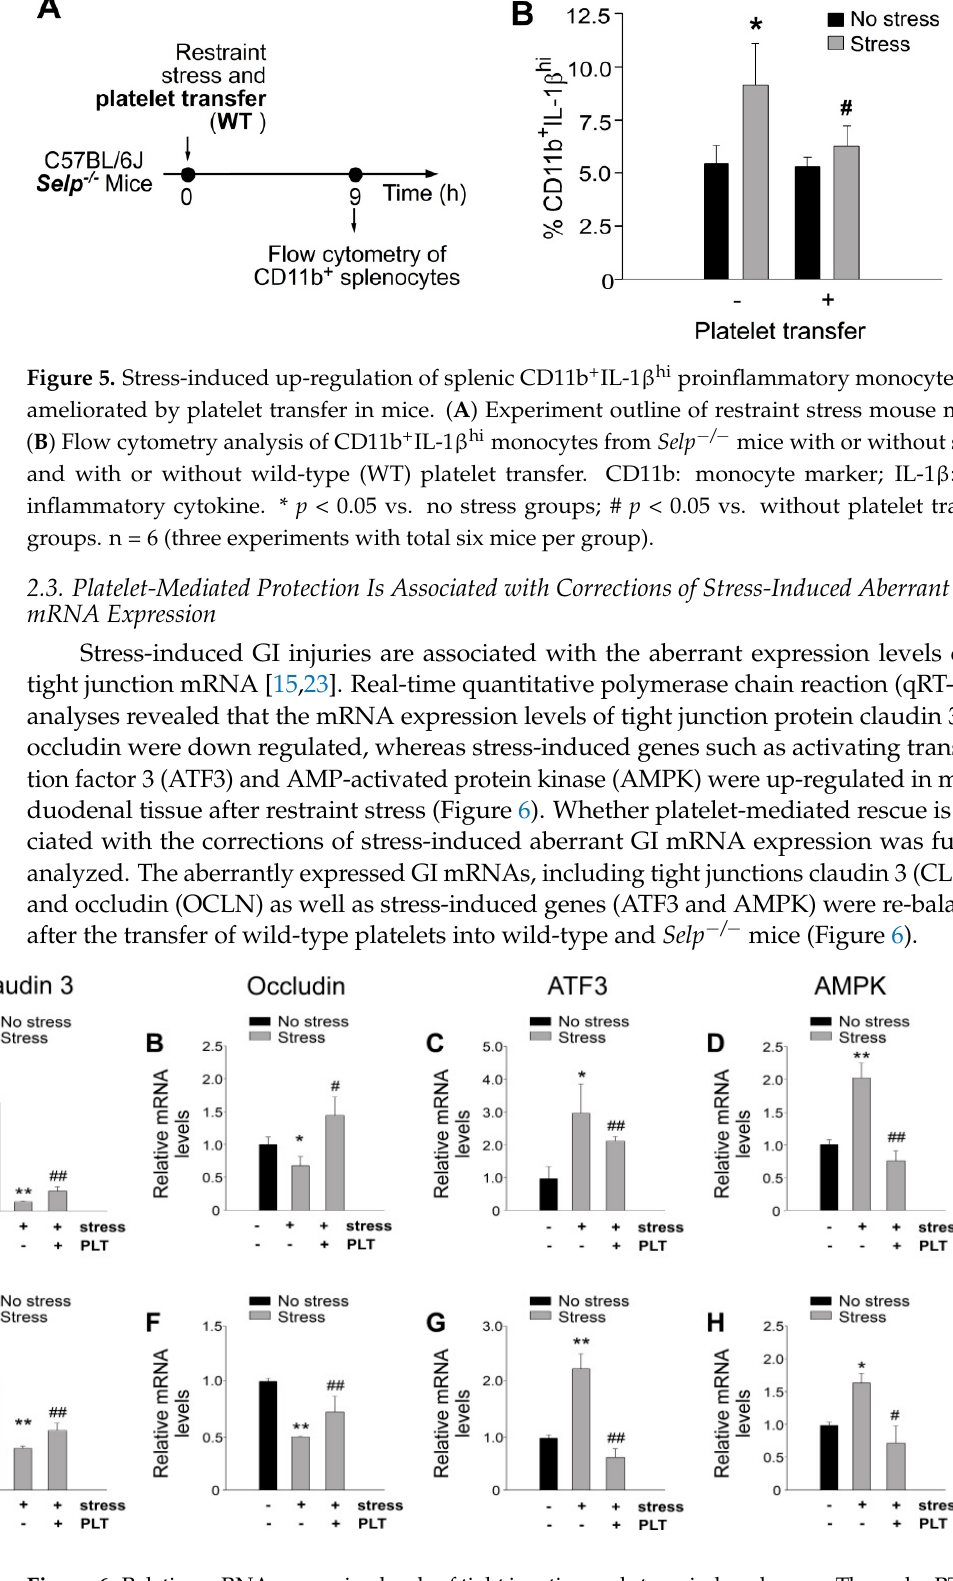
h. ND: not detected. ** p < 0.01, vs. respective stress groups. n = 6 (three experiments with total six mice per group).